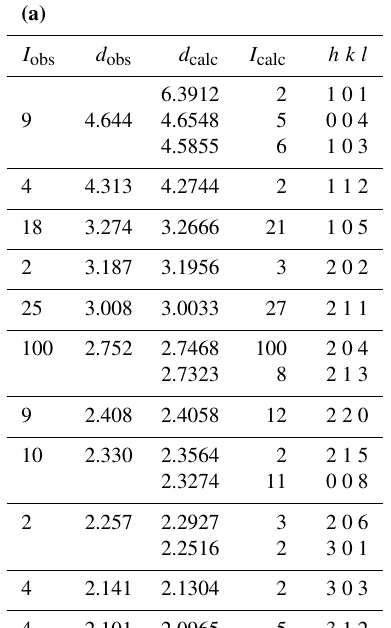
vided a structure entirely consistent with the unprotonated alluaudite structure